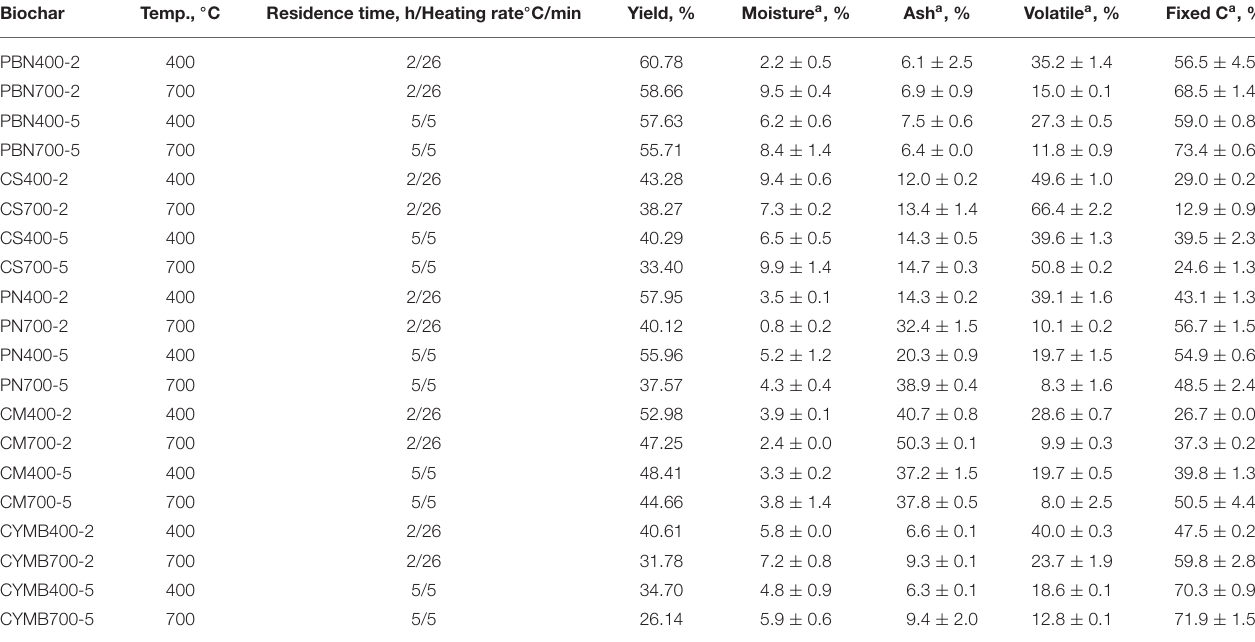
TABLE 1 | Proximate analysis of corn pine nuggets (PBN), corn stover (CS), pine needle (PN), cow manure (CM), and cypress mulch barks (CYMB) made biochars produced under different pyrolytic conditions. Biochar Temp., ◦